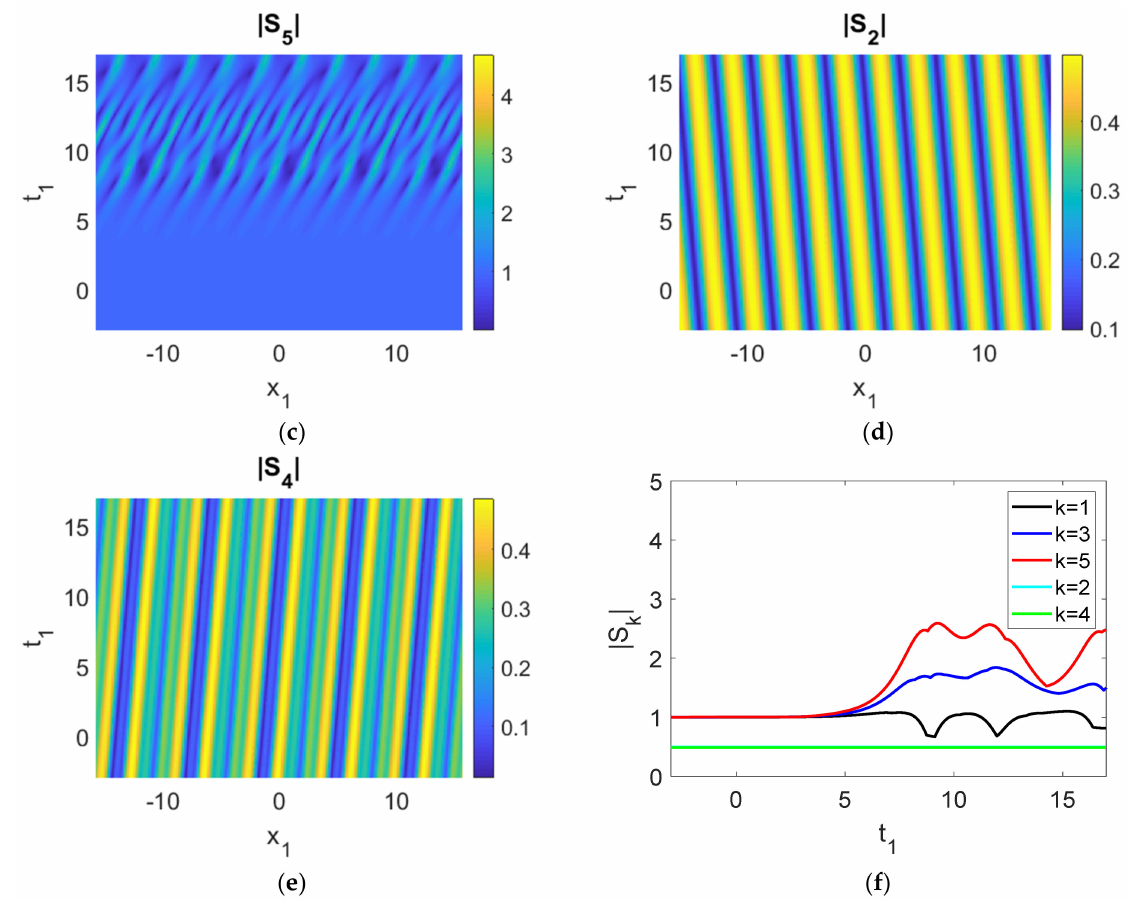
Figure 7. ( a – e ) Control experiment (only | S 1 |, | S 3 | and | S 5 | oscillate, | S 2 |, | S 4 | move as plane wave); ( f ) time history of the moduli of the envelopes, | S k |. Parameters used were c g 1 = 2, c g 3 = 1, c g 5 = 0.5, c g 2 = − 0.1, c g 4 = 0.1, γ 1 = 1, γ 3 = γ 5 a = − 1, γ 2 = γ 4 = 0,